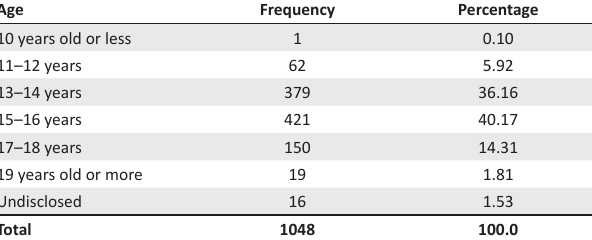
TABLE 1: Age distribution of respondents in the two local council development areas of Lagos State ( n = 1048). Age